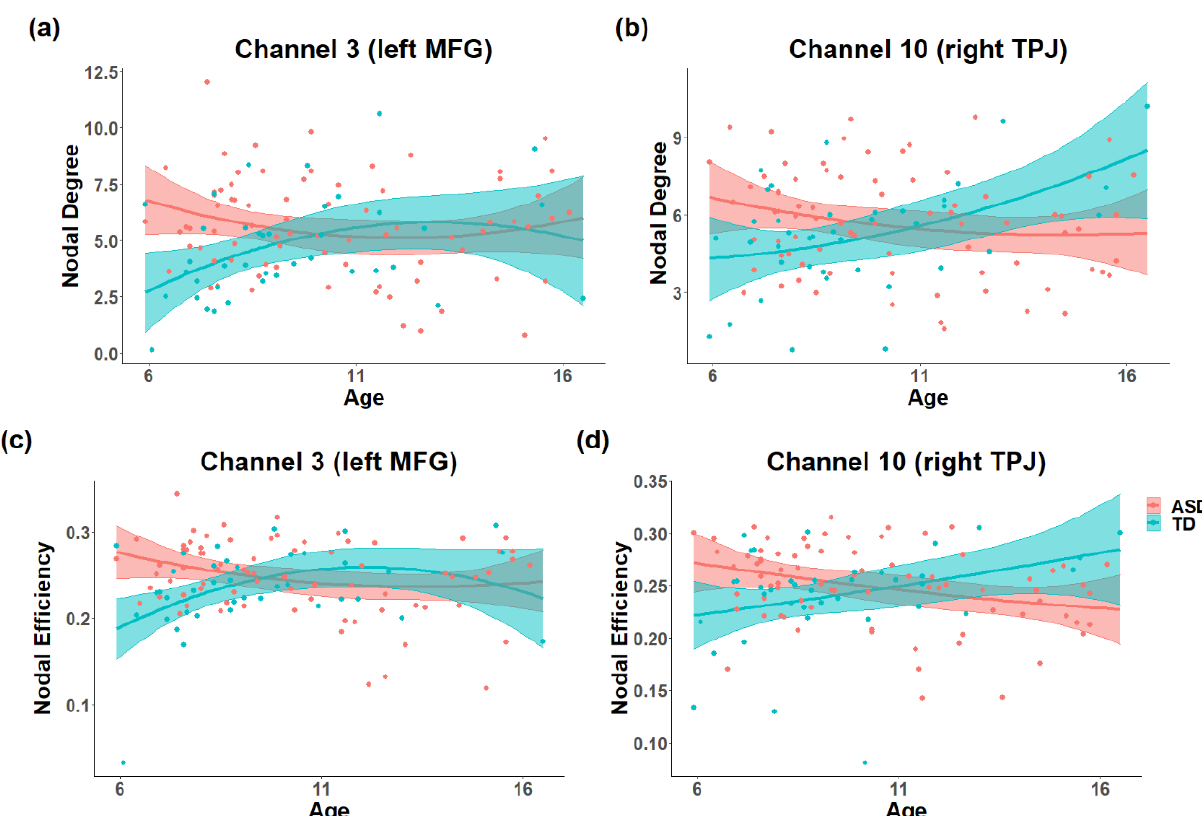
Figure 3. The plotted marginal effect curves of nodal metrics and age. TD participants showed an inverted U-shaped trajectory of the nodal degree ( a ) and nodal efficiency ( c ) in channel 3 in the left MFG, while participants with ASD showed U-shaped patterns. Furthermore, participants with ASD showed an age-related decrease in nodal degree ( b ) and nodal efficiency ( d ) in channel 10 in the right TPJ while the trajectory of TD was opposite.